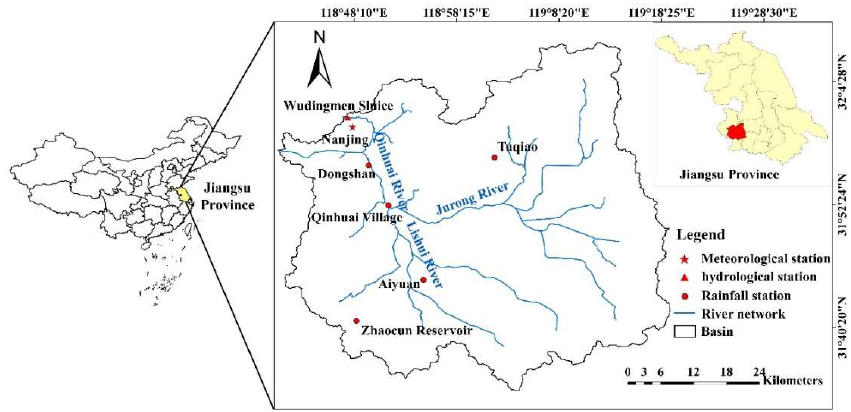
Figure 1. The geographical location of the river network and stations in the Qinhuai River Basin.